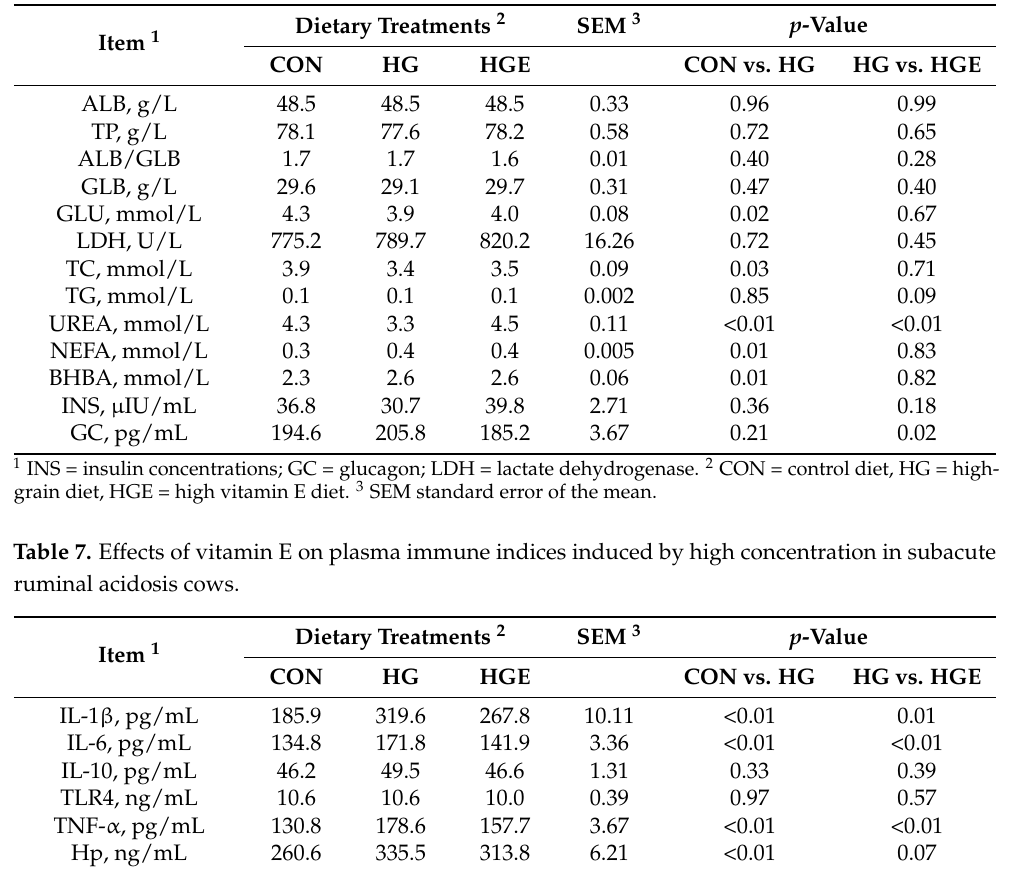
Table 6. Effects of vitamin E on plasma biochemical indices induced by high concentration in subacute ruminal acidosis cows.